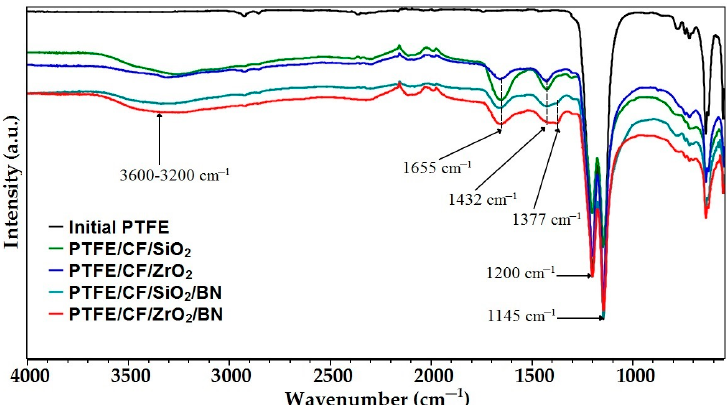
Figure 7. IR spectra of the PTFE and PCM friction surface.